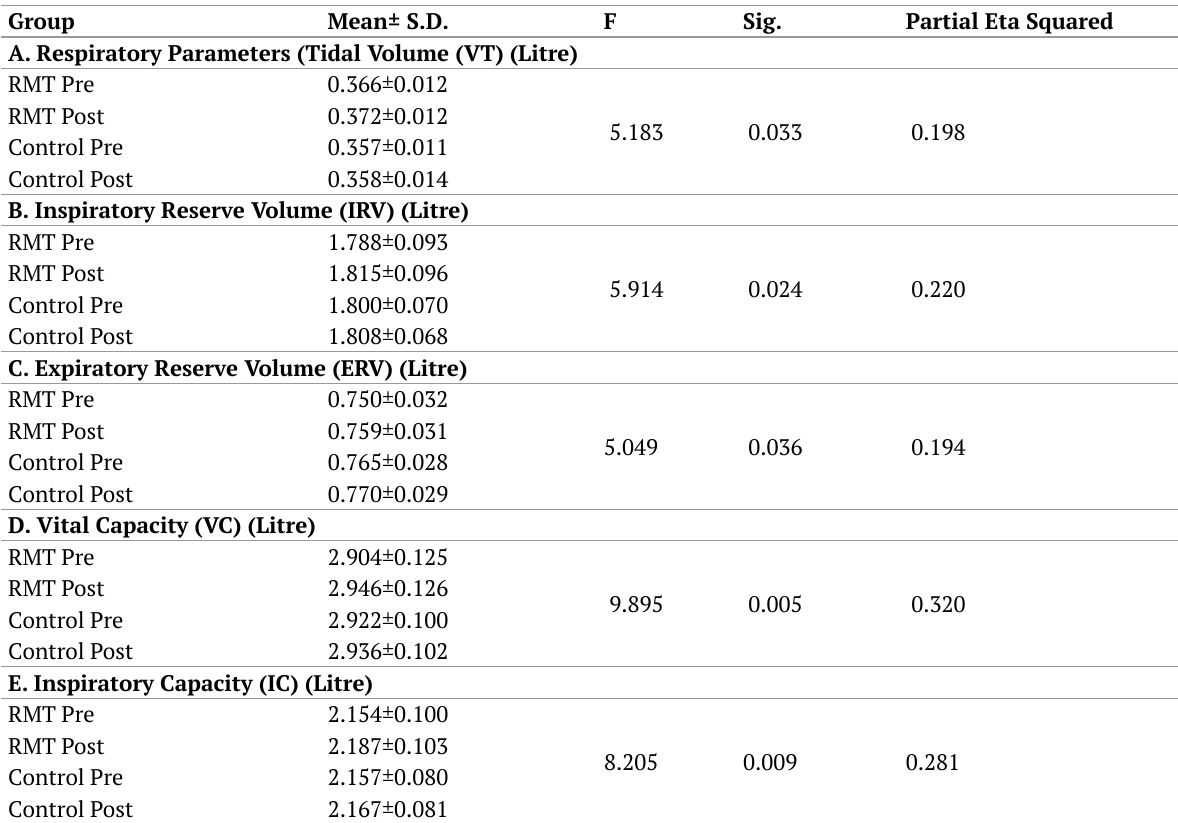
Table 5. Analysis of Covariance (ANCOVA) between Group B (RMT) and Group C (control) on respiratory parameters Group Mean± S.D. F Sig. Partial Eta